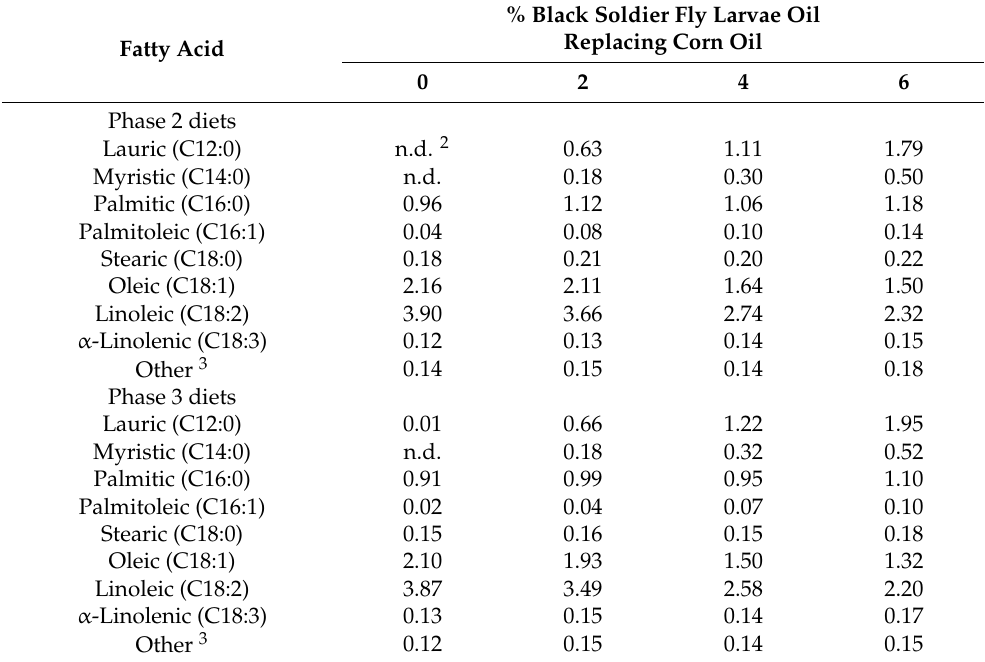
Table 3. Analyzed fatty acid composition (g/100 g of diet) of experimental phase 2 (day 14 to 25), and phase 3 (day 25 to 40) diets. As fed basis 1